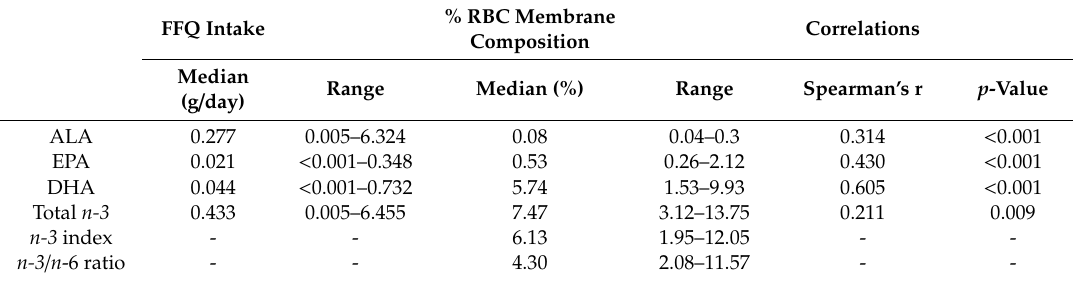
Table 3. Median n-3 PUFA intake assessed using food frequency questionnaires (FFQ) and median RBC n-3 PUFA composition, as well as correlations between the two ( n = 152). % RBC Membrane FFQ Intake Composition